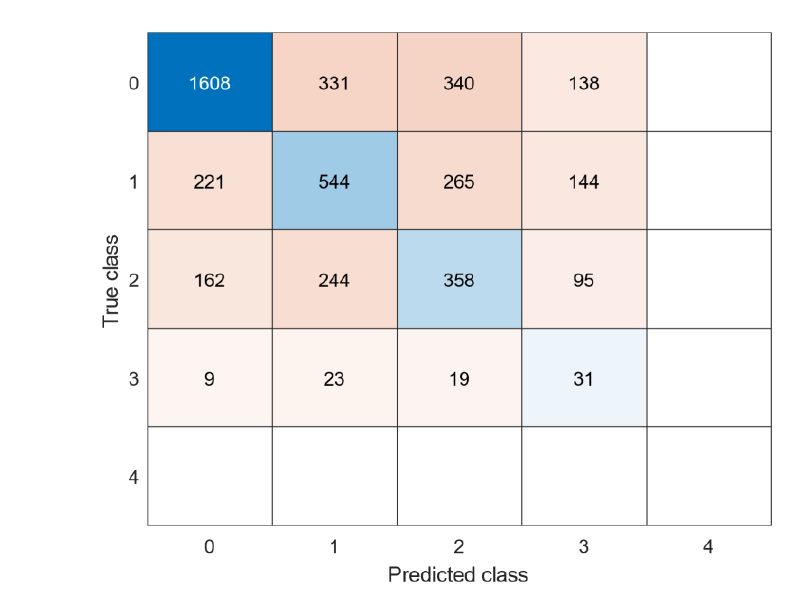
Figure 4. Confusion matrix: generalized model of lower extremities dystonia.